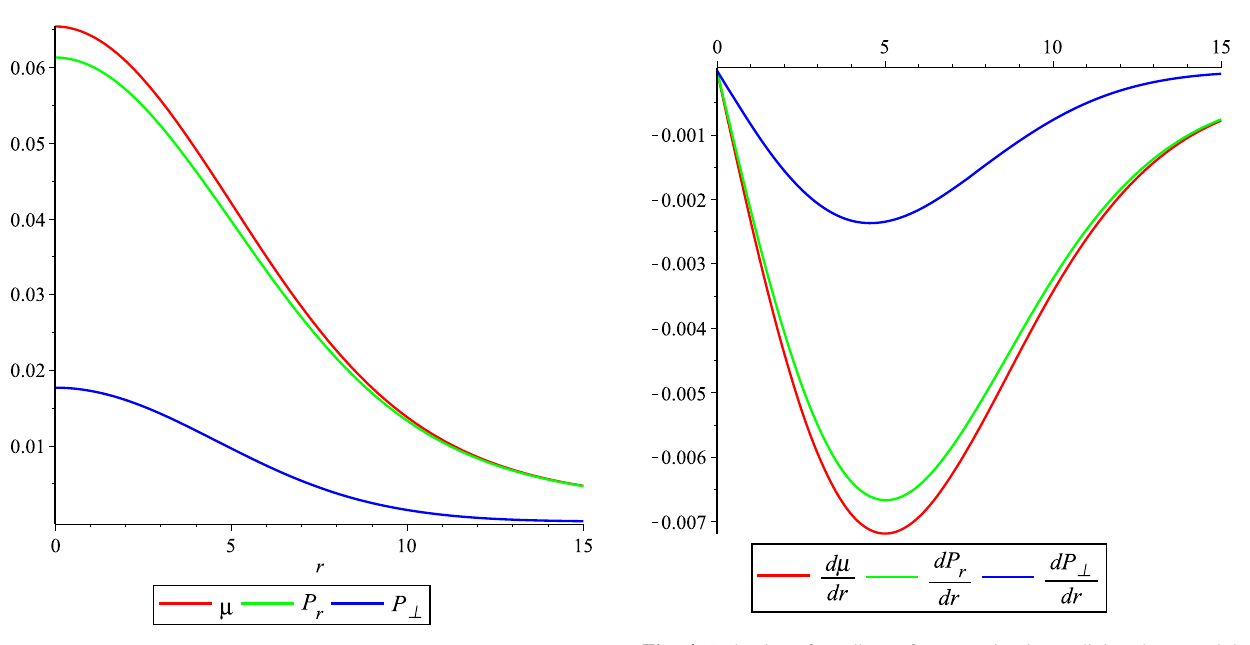
Fig. 4 Behavior of gradient of energy density, radial and tangential Fig. 3 Behavior of energy density, radial and tangential pressure with- pressure without DM out DM conditions for DM with various choices of r and (cid:2) = 100 Table1 Gradientsofenergydensity,radialandtangentialpressurewith (cid:2) = 100 are shown in Table dP ⊥ dP r r d μ dr dr dr